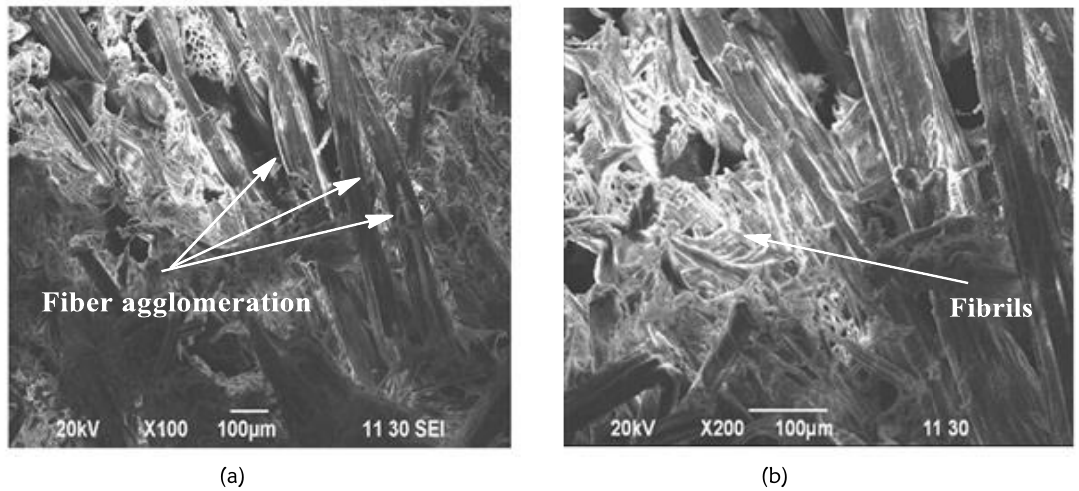
Figure 14: (a), (b) SEM micrographs of untreated fiber composite